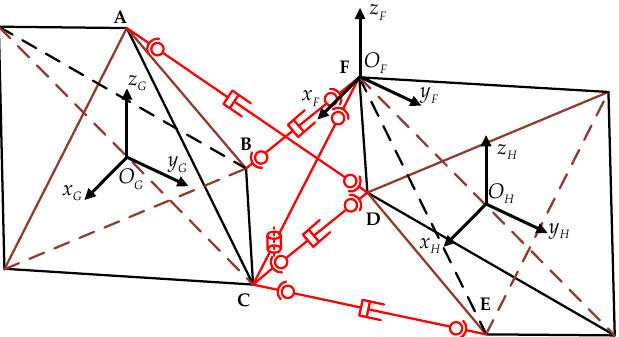
Figure 8. The sketch of the wing morphing mechanism and the establishment of coordinate systems. The red column represents the rotating pair. The red circle represents the ball joint. The red square represents the mobile pair.